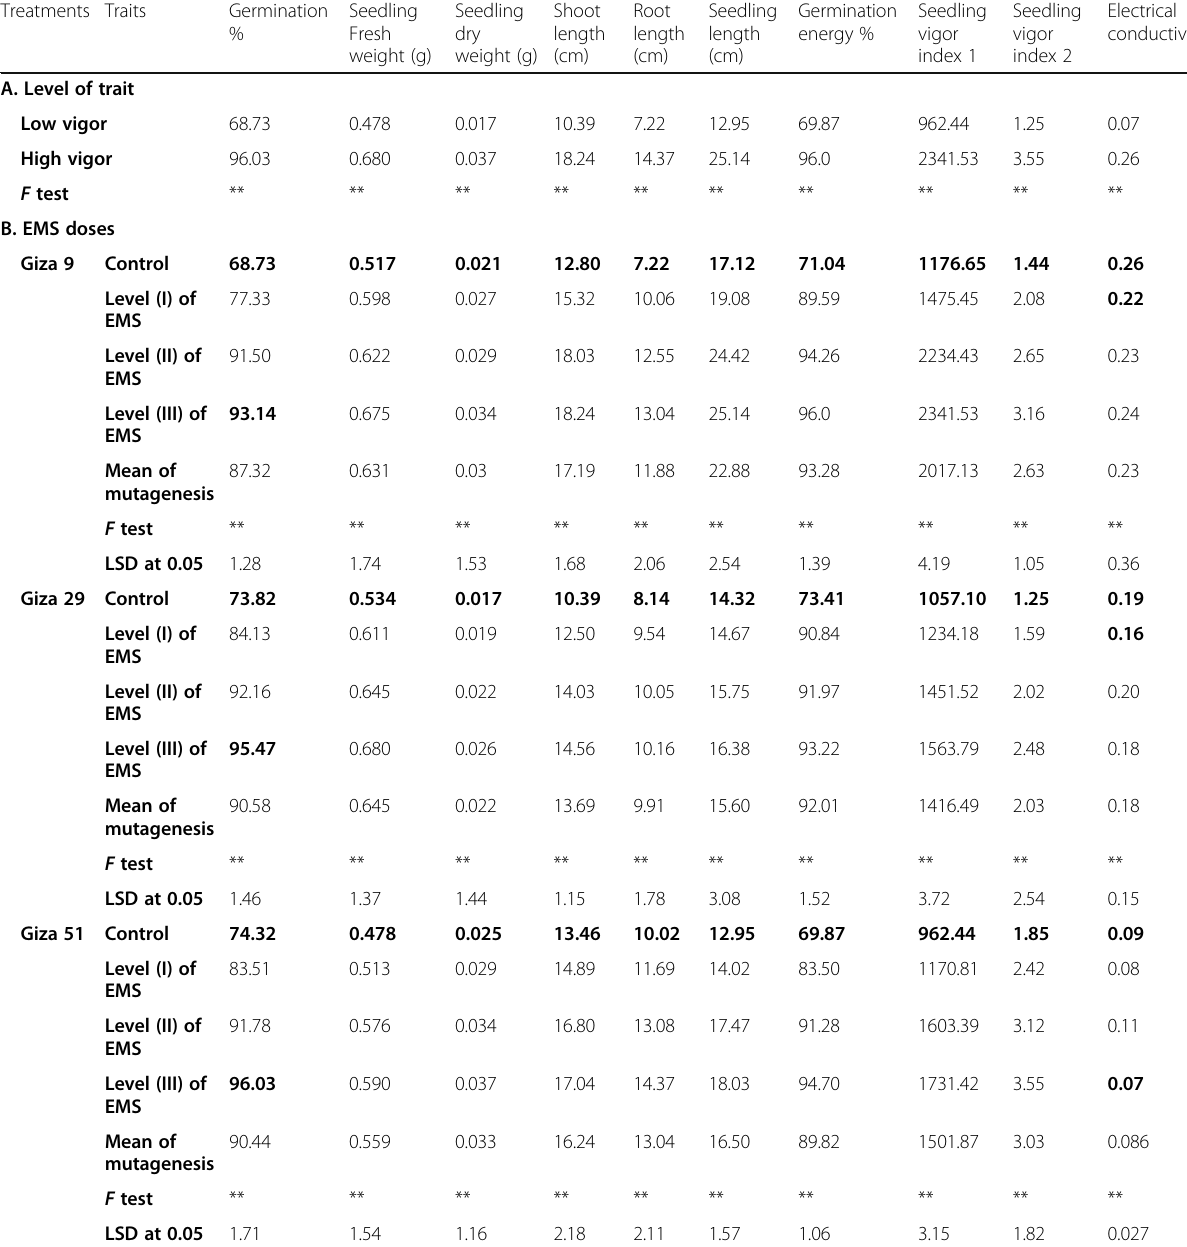
Table 1 Average for lentil M2 seedling traits under control and ethyl methane sulfonate (EMS) Treatments Traits